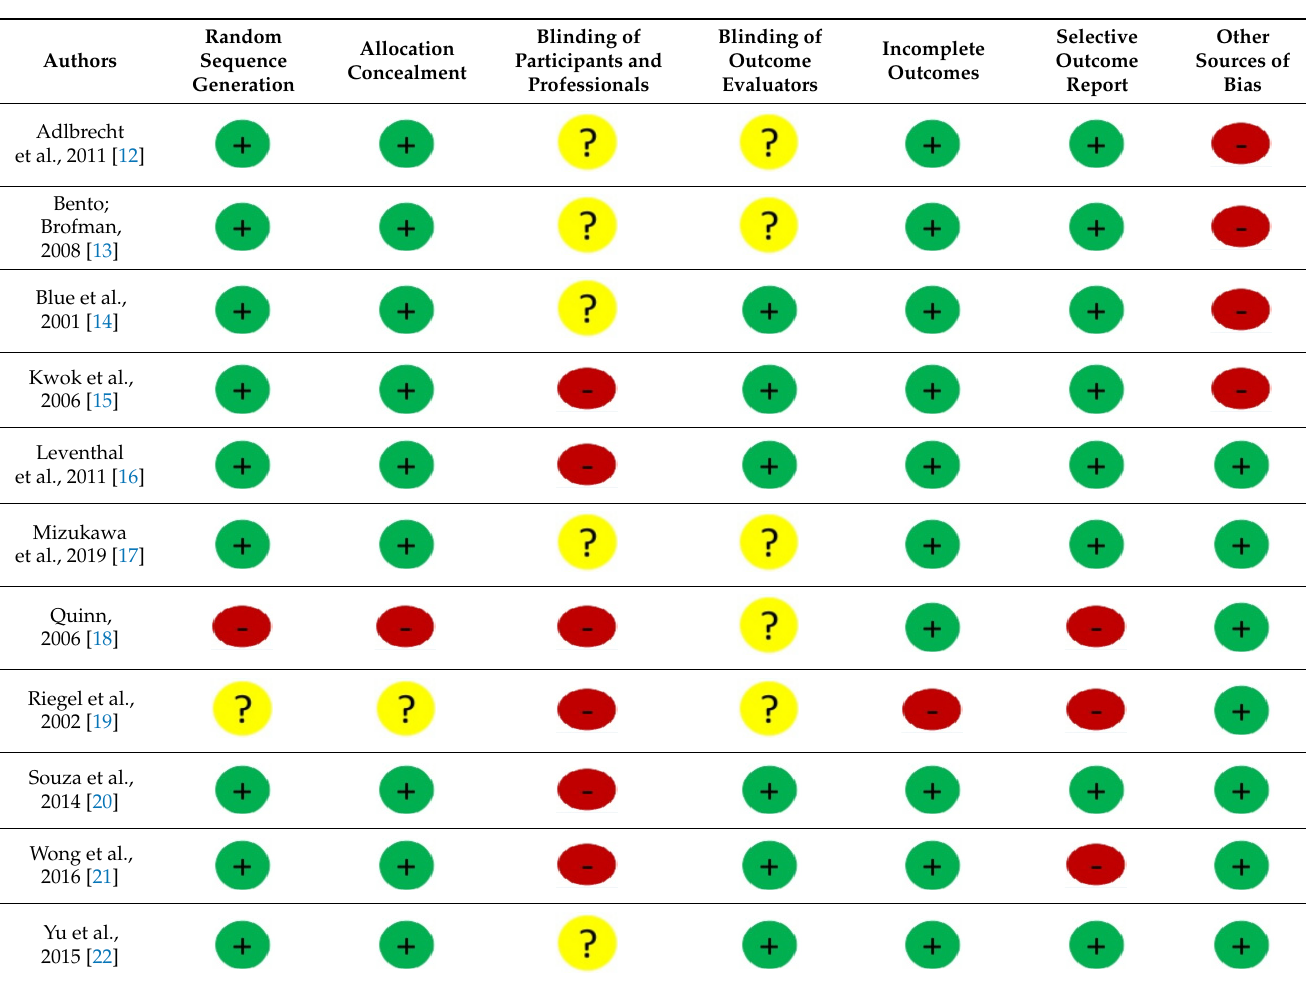
Table A2. Risk of bias assessment.